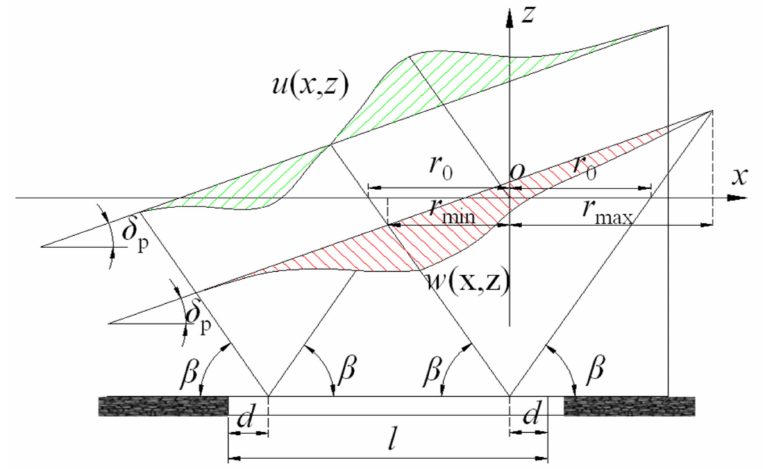
Figure 7. Deformation model of inclined surface in horizontal seam mining.